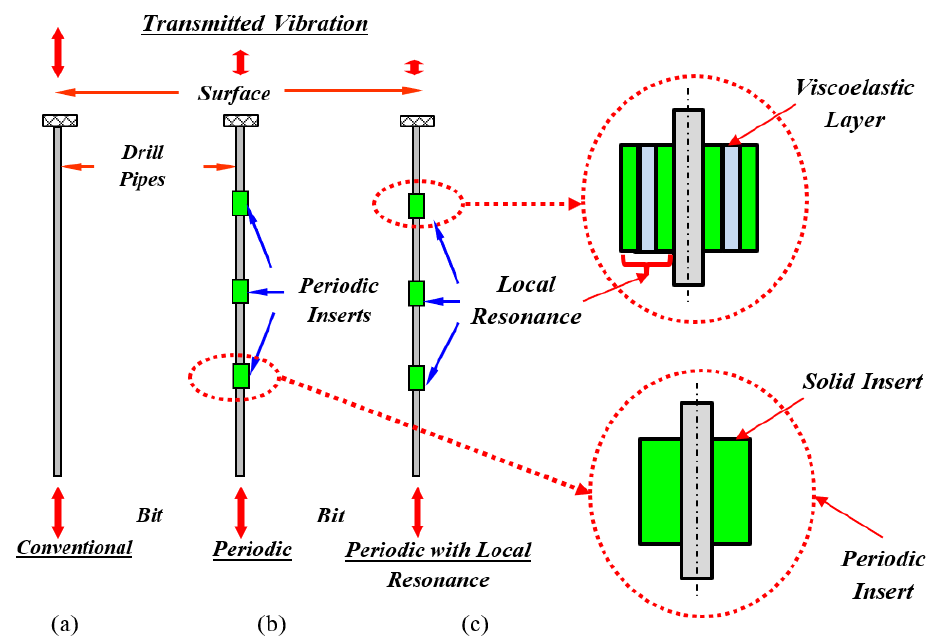
Figure 1. Schematic drawings of conventional ( a ), periodic ( b ), and periodic with local resonant inserts ( c ) drill-strings.